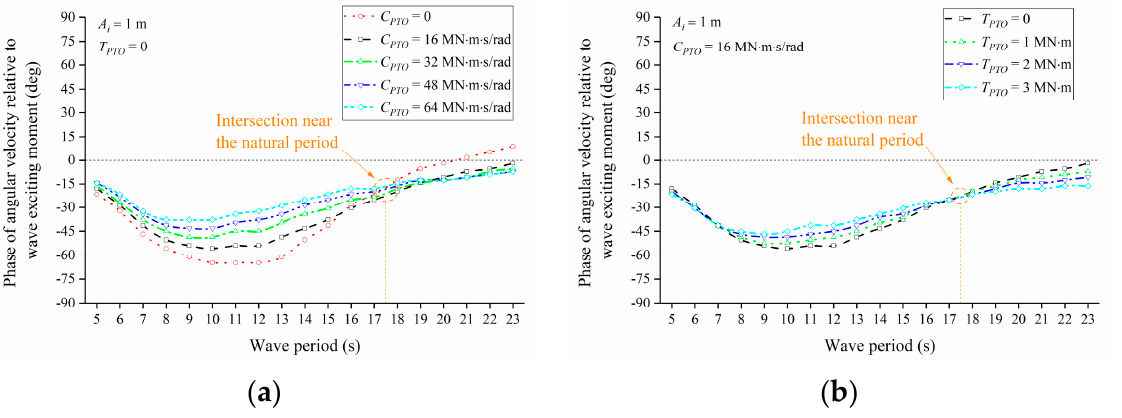
Figure 21. The phases of angular velocity relative to wave exciting moment under unit-amplitude regular waves: ( a ) various values of C PTO and T PTO = 0; ( b ) various values of T PTO and C PTO = 16 MN · m · s/rad.